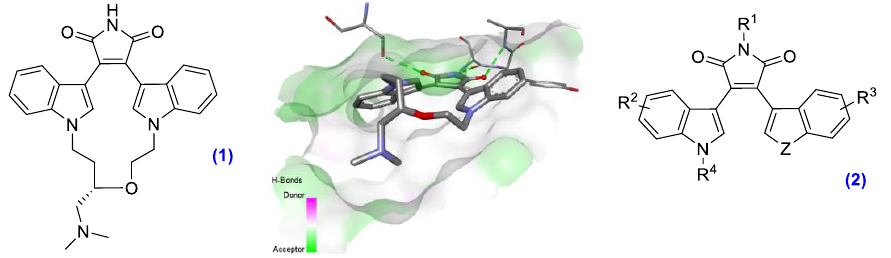
Figure 7. The bisindolylmaleimide ruboxistaurin (1) in the PDK1 kinase pocket (PDB: 1UU3) and the target compounds (2) .